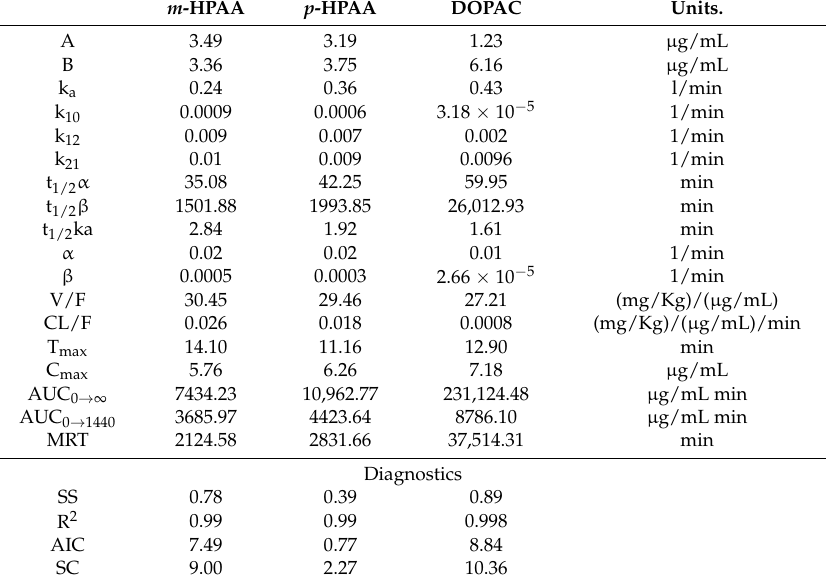
Table 3. Pharmacokinetic parameters of the flavonoid biotransformation products present in the anxiolytic fraction of T. americana in plasma of ICR mice; n = 10. The analytes fit into the two-compartment model. m -HPAA p -HPAA DOPAC